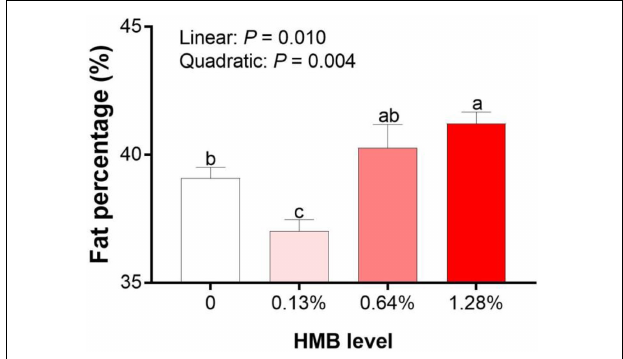
FIGURE 1 | Effects of dietary HMB supplementation on fat percentage of Bama Xiang mini-pigs. Data are presented as mean ± SEM ( n = 8). a , b , c Values with different letters are significantly different among dietary HMB treatments ( P <